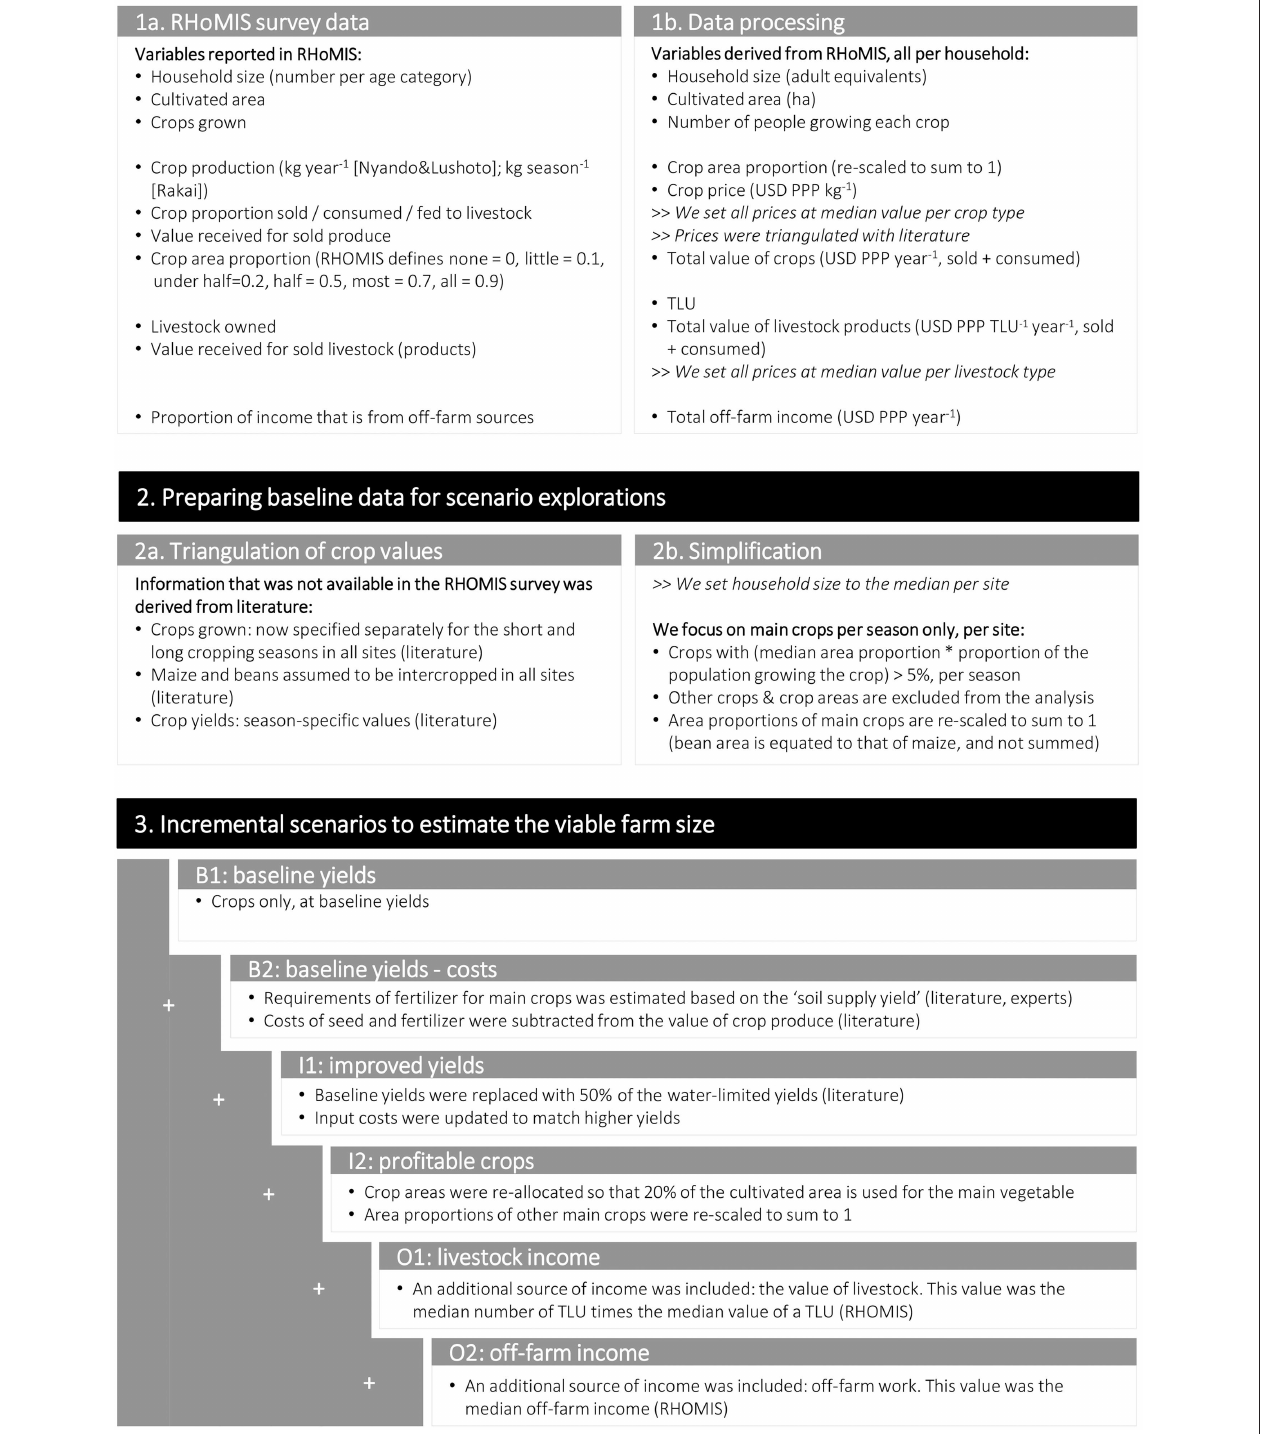
Frontiers in Sustainable Food Systems |